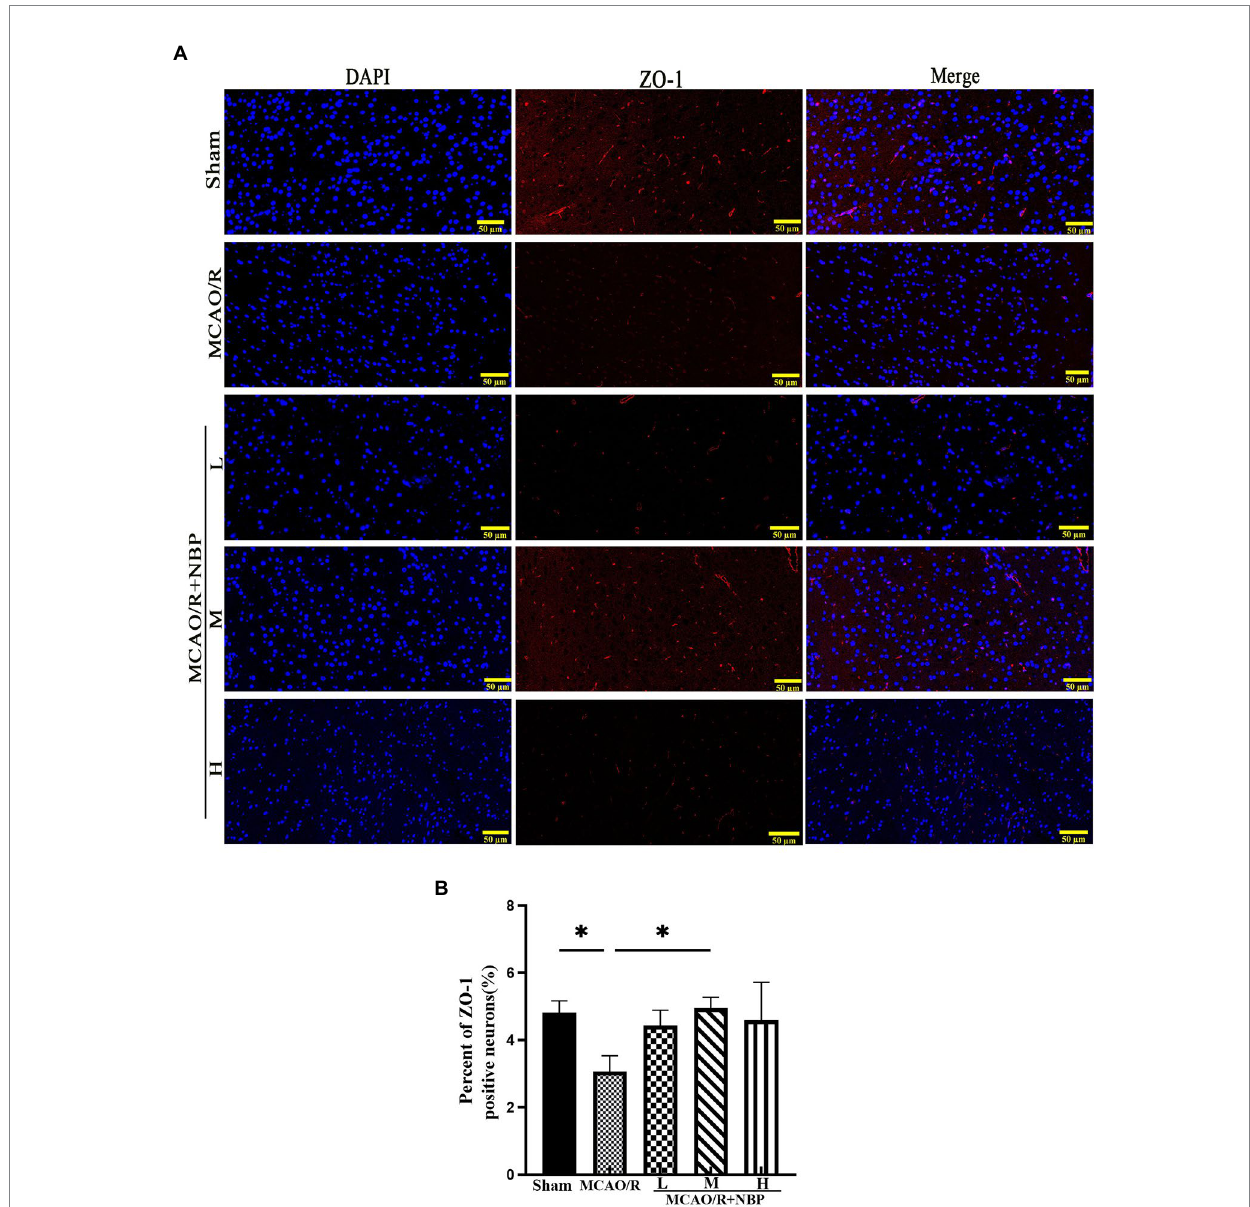
FIGURE 4 The ZO-1 tight junction protein of BBB. (A) The expression of ZO-1. (B) The qualification of ZO-1. BBB, the blood–brain barrier. * p < 0.05; ** p < 0.01; *** p < 0.001. The values represent the mean ± SD, n =